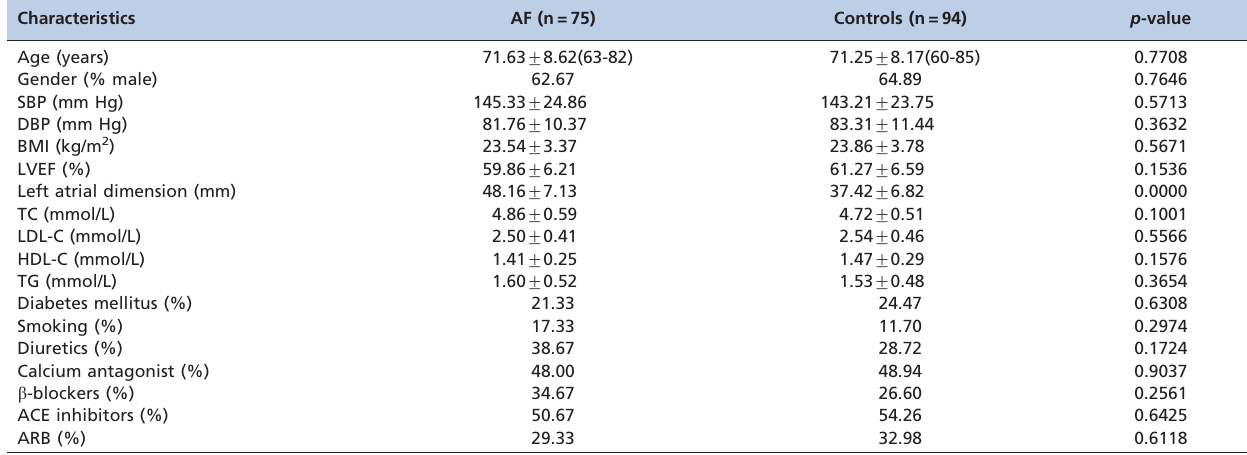
AF, atrial fibrillation; SBP, systolic blood pressure; DBP, diastolic blood pressure; BMI, body mass index; LVEF, left ventricular ejection fraction; TC, total cholesterol; LDL-C, low-density lipoprotein cholesterol; HDL-C, high-density lipoprotein cholesterol; TG, triglycerides; ACE, angiotensin-converting enzyme ; ARB, angiotensin receptor blocker.